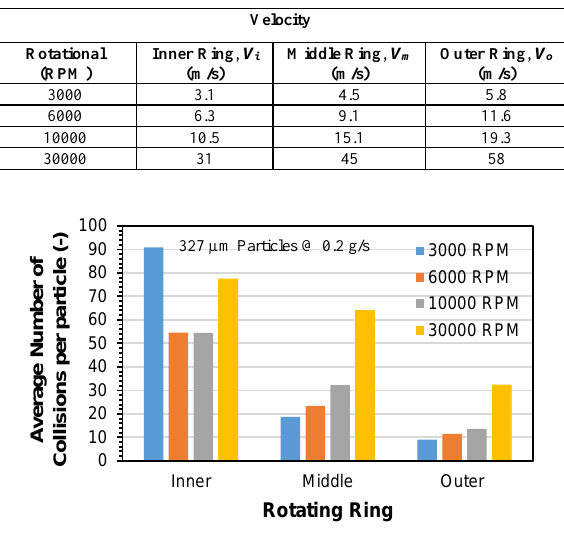
Fig. 2. Average number of collisions per particle at different rotating rings before they leave the